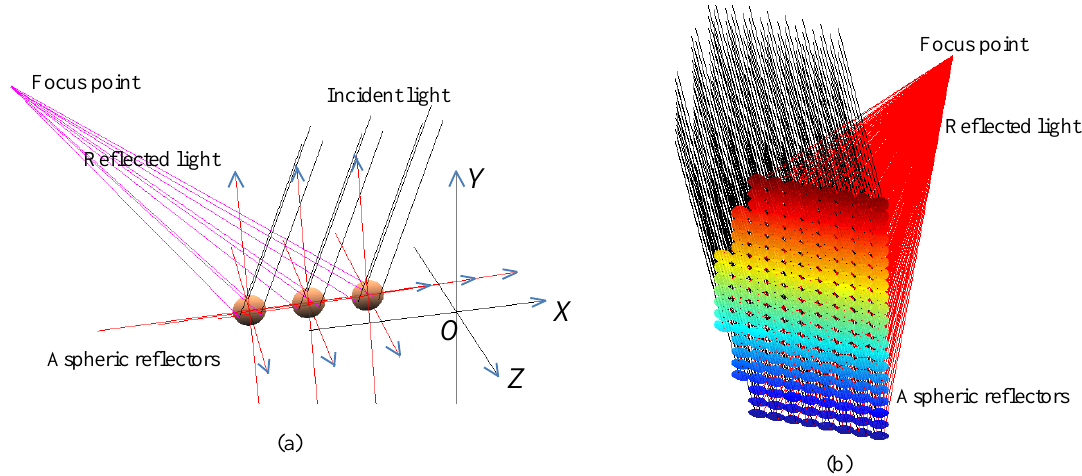
Figure 9. The optical path simulation of the concentrator system. ( a ) The optical path diagram of three aspheric reflectors; ( b ) the optical path diagram of 190 aspheric reflectors.